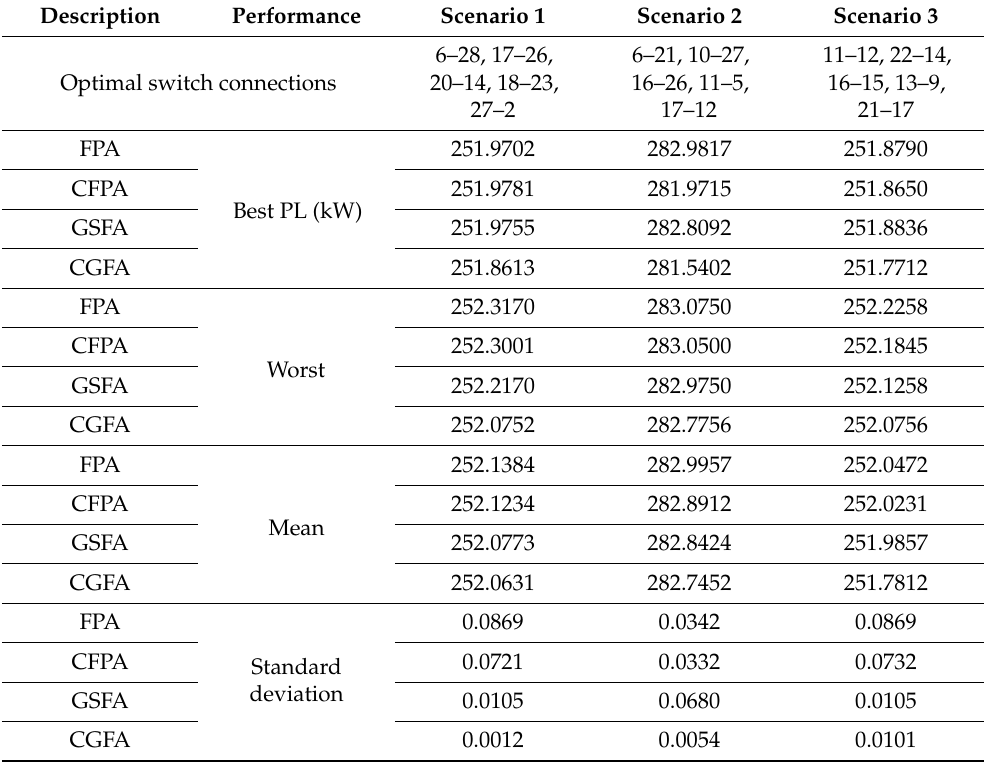
Table 5. Optimal tie-switch connections and power losses through the DNR in the IEEE 33-bus system.